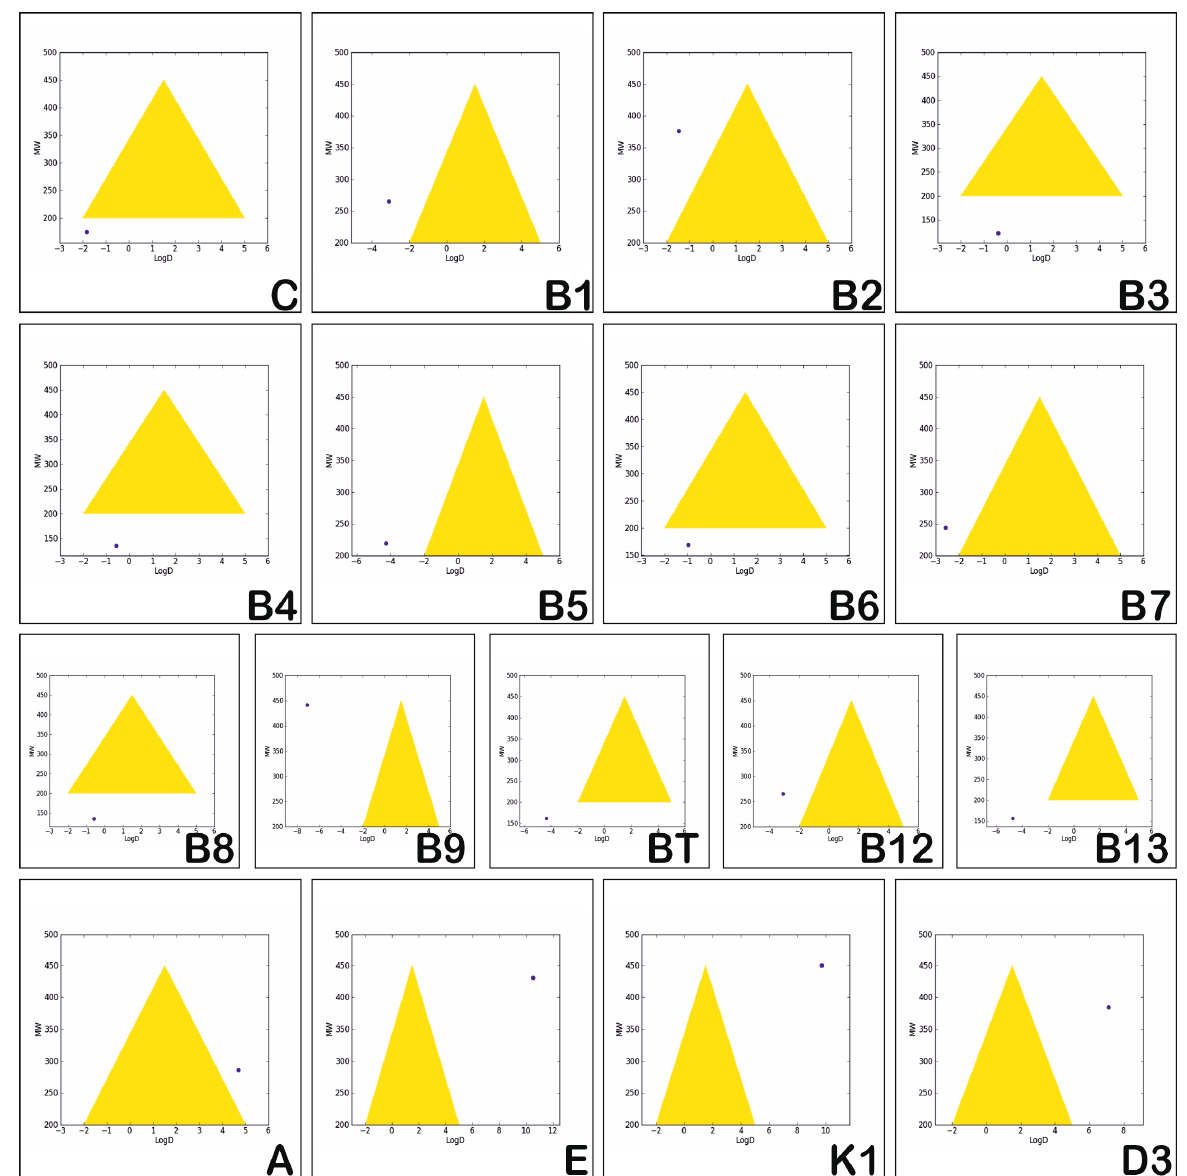
Figure 3. Assessment of the permeability and metabolic stability of the hydrosoluble and liposoluble vitamins. Figure 3 illustrates that none of the investigated vitamins reflects permeability and metabolic stability. The liposoluble vitamins have high values for both logD and MW, which reflects poor metabolic stability, compared with the hydrosoluble vitamins which usually have low values for both logD and MW, reflecting low permeability.